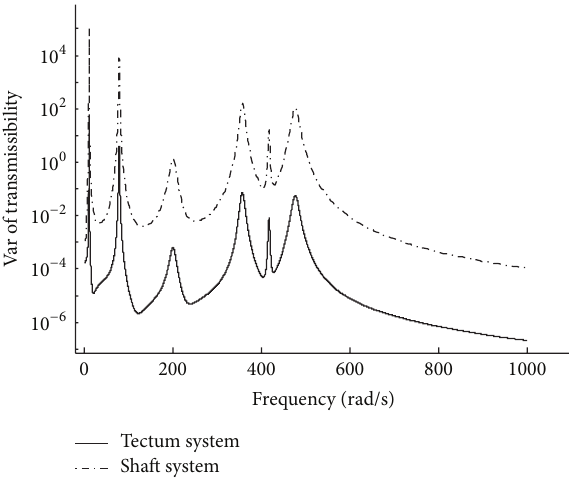
Figure 6: Variance of the path transmissibility of the excitation frequency characteristic